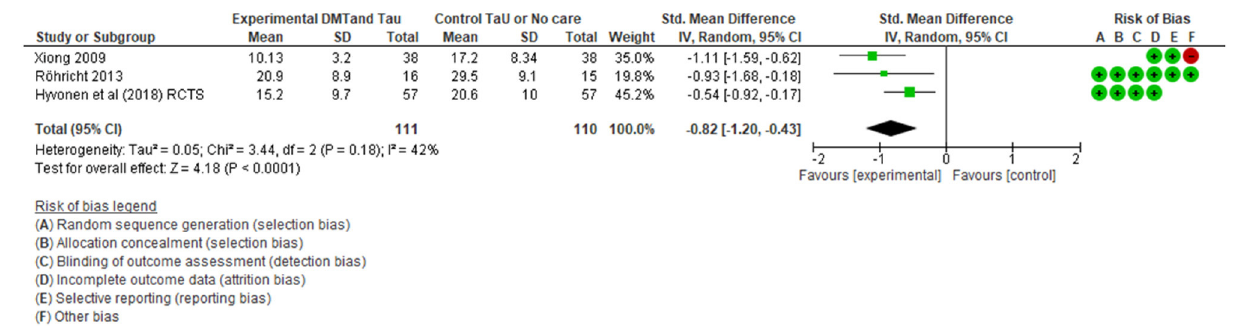
FIGURE 9 | Sensitivity analysis for between groups—RCTs only with moderate to low risk (post DMT vs.